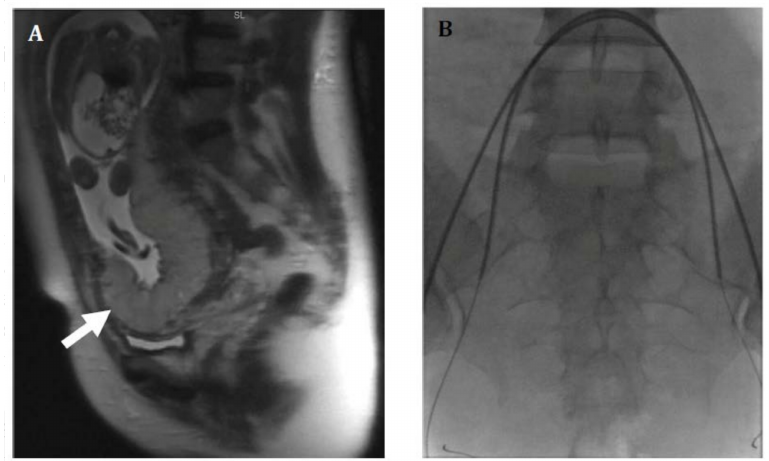
Figure 2. Thirty-six-year-old female with placenta increta. ( A ) Sagittal T2 Half-Fourier-Acquired Single-shot Turbo spin Echo (HASTE) magnetic resonance (MR) image shows a bulging placenta at the lower uterine segment (arrow) with disorganized architecture, suggestive of placenta increta. Complete placental previa as well as an omphalocele were also noted. ( B ) Prophylactic bilateral internal iliac artery occlusion balloons were placed prior to cesarean hysterectomy. Patient underwent cesarean hysterectomy at 22 weeks with delivery of a demised fetus. Patient required extensive lysis of adhesions between the lower uterine segment and